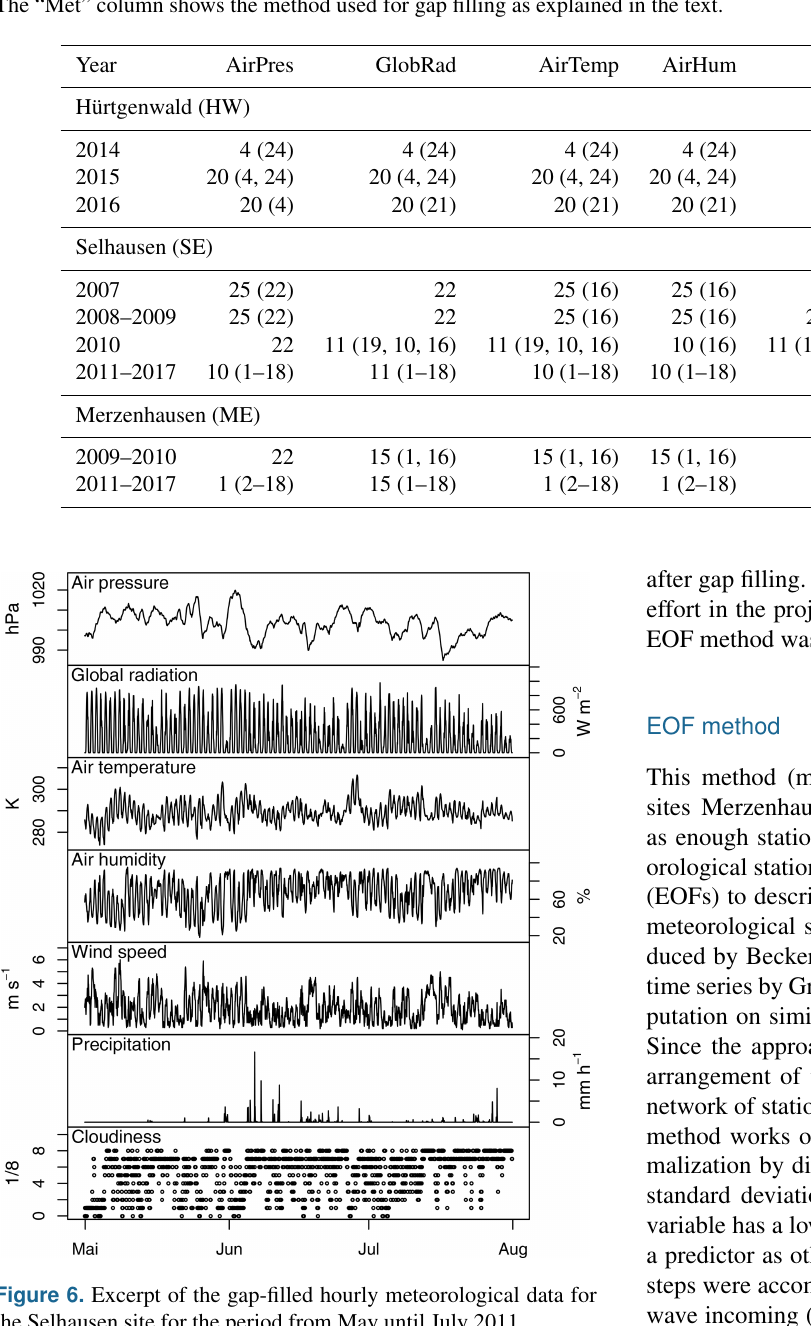
Table 10. Source of meteorological data given as station IDs as defined in Table 9. Station IDs in parentheses are stations used for gap filling. The “Met” column shows the method used for gap filling as explained in the text.